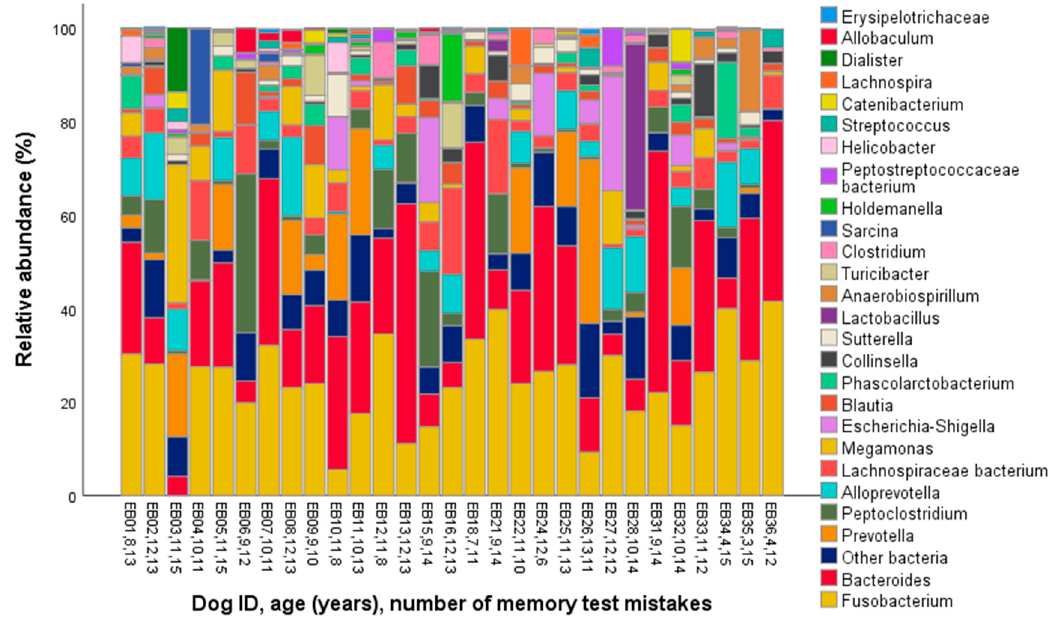
Figure 2. Genus-level gut microbiota composition in the fecal samples of 29 companion dogs.